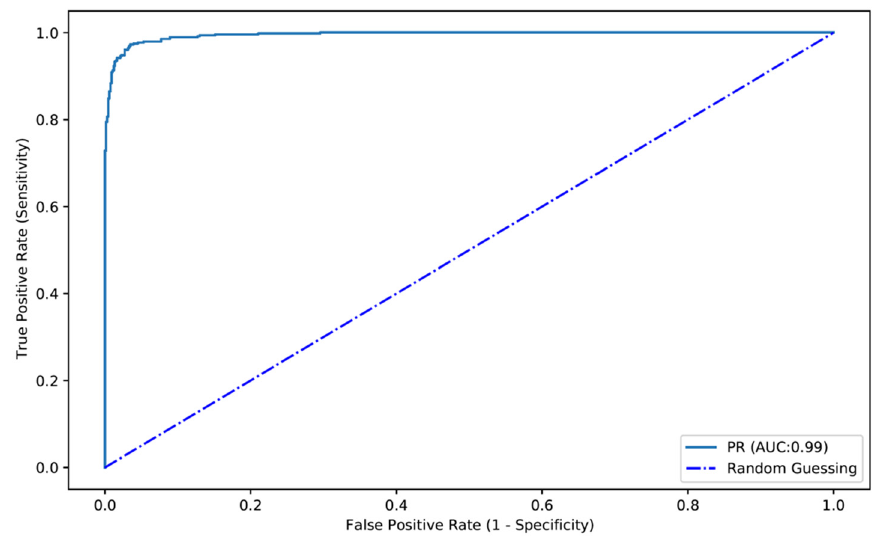
Figure 4. ROC analyses of the network’s performance in the detection of protruding lesions vs. normal colonic mucosa/other findings. ROC—receiver operator characteristics. PR—protruding lesion. Table 2. Three-fold cross